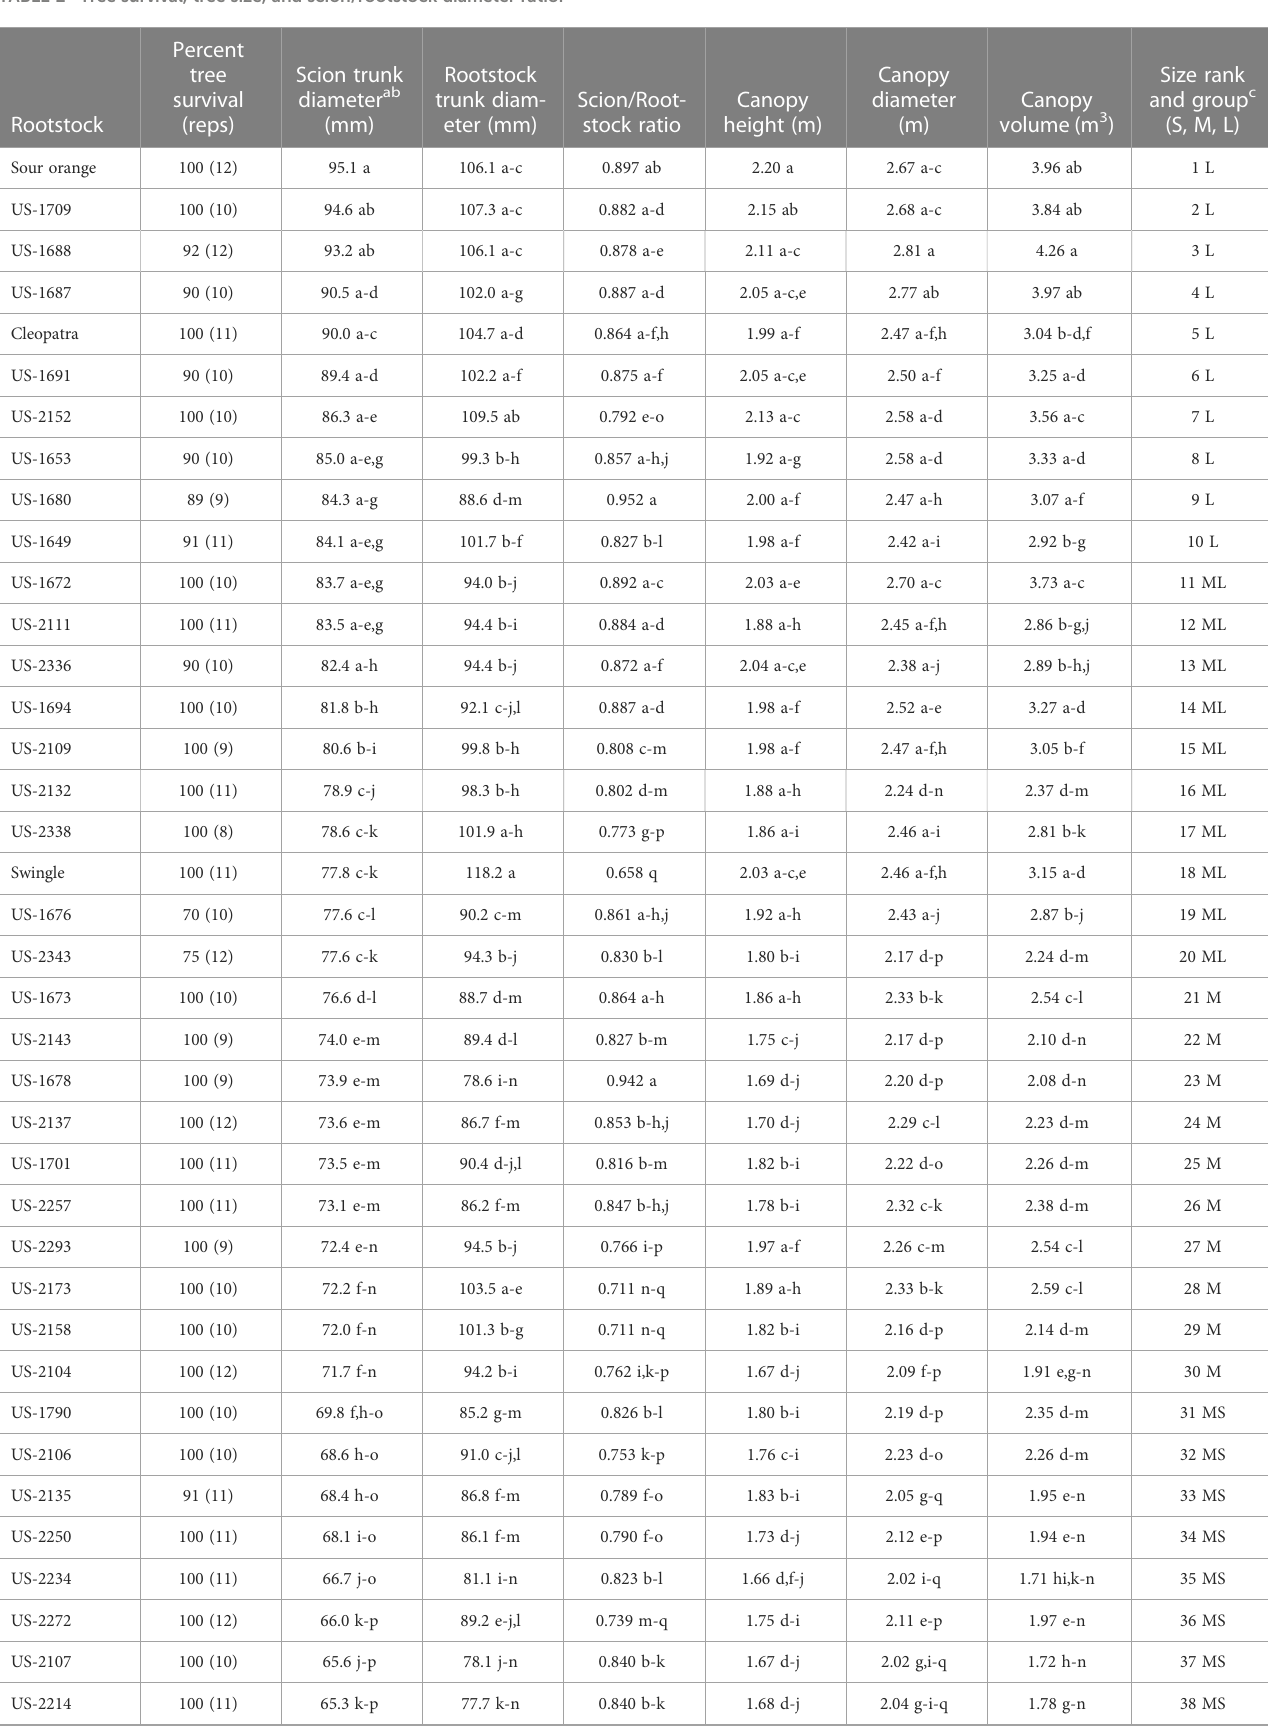
TABLE 2 Tree survival, tree size, and scion/rootstock diameter